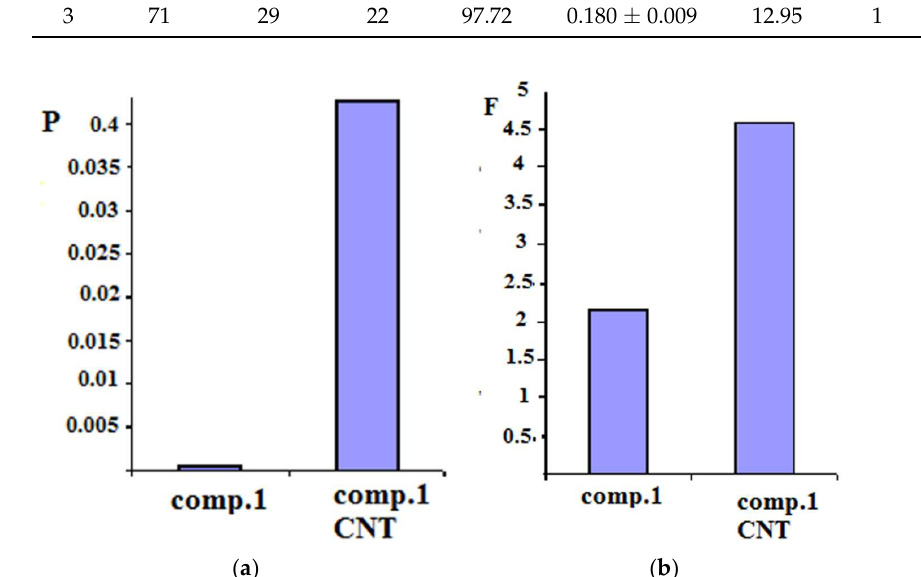
Figure 12. Comparison of the flux normalized to the membrane thickness P [kg (cid:215) µm (cid:215) m −2 (cid:215) h −1 ] ( a ) and the separation factor f ( b ) for membranes based on the PVA-PAA mixture and PVA-PAA with MWCNT (1 wt.%) while separating the 50/50 (wt./wt.) toluene/n-heptane mixture.